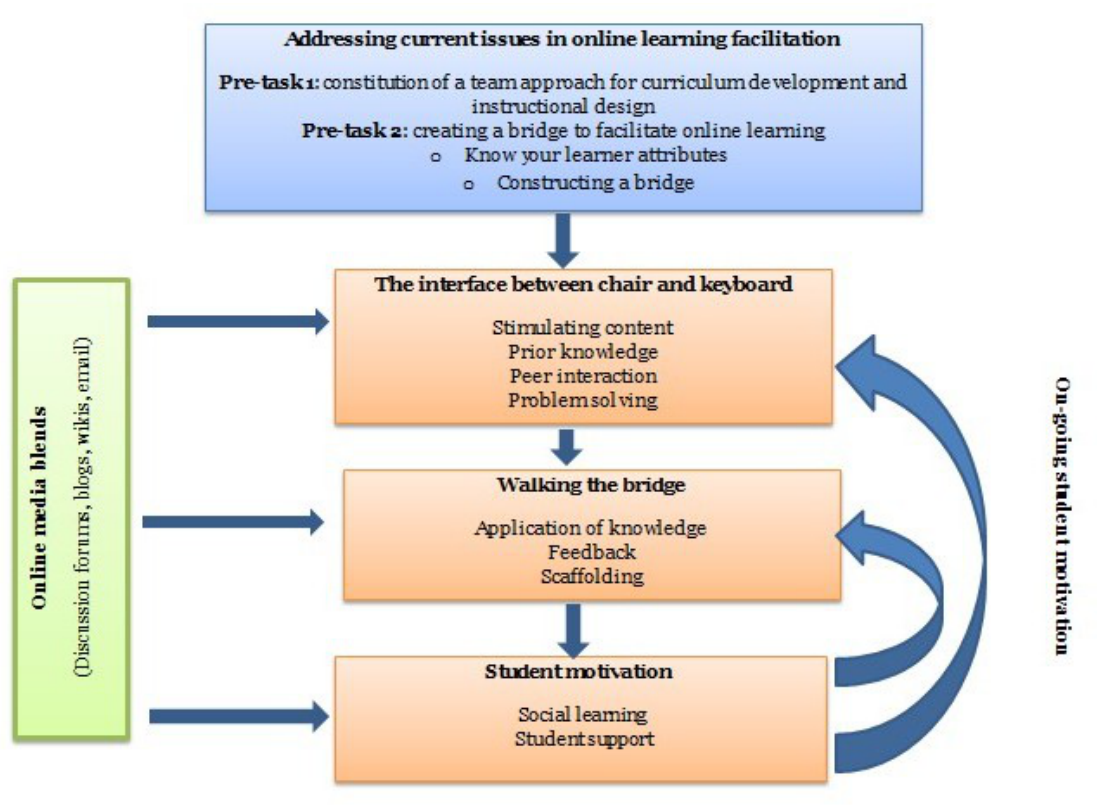
Figure 1. Guidelines for the facilitation of interactive online learning